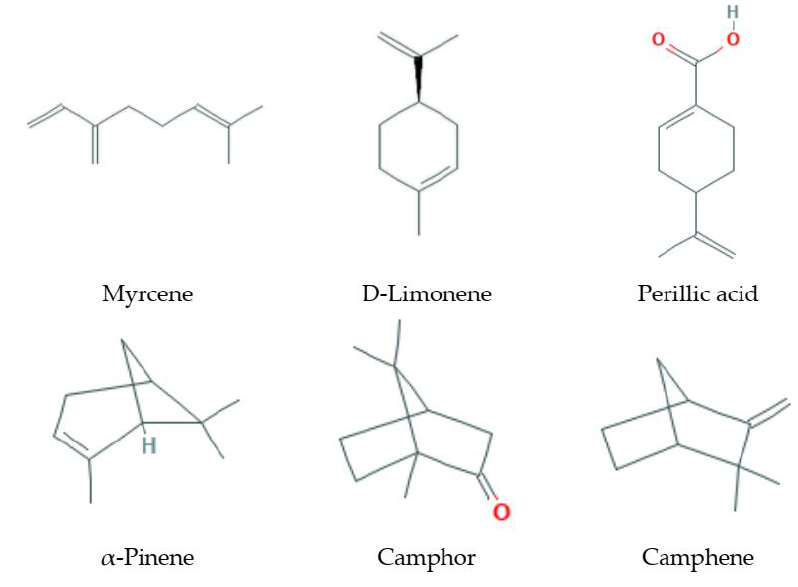
Figure 1. Some monoterpenes that increase lifespan and delay age-related diseases.